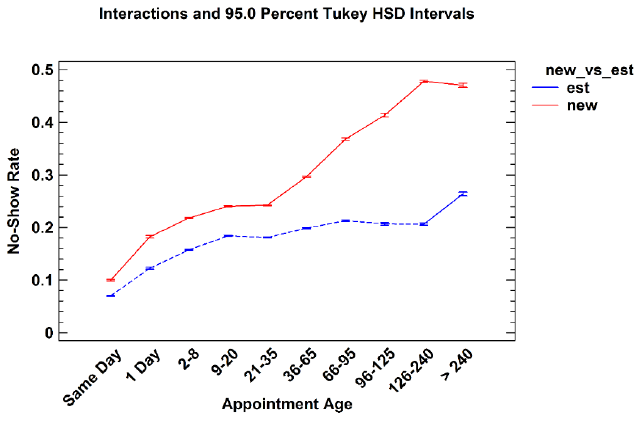
Figure 5. No-show rates for new and established patients by appointment age groups.